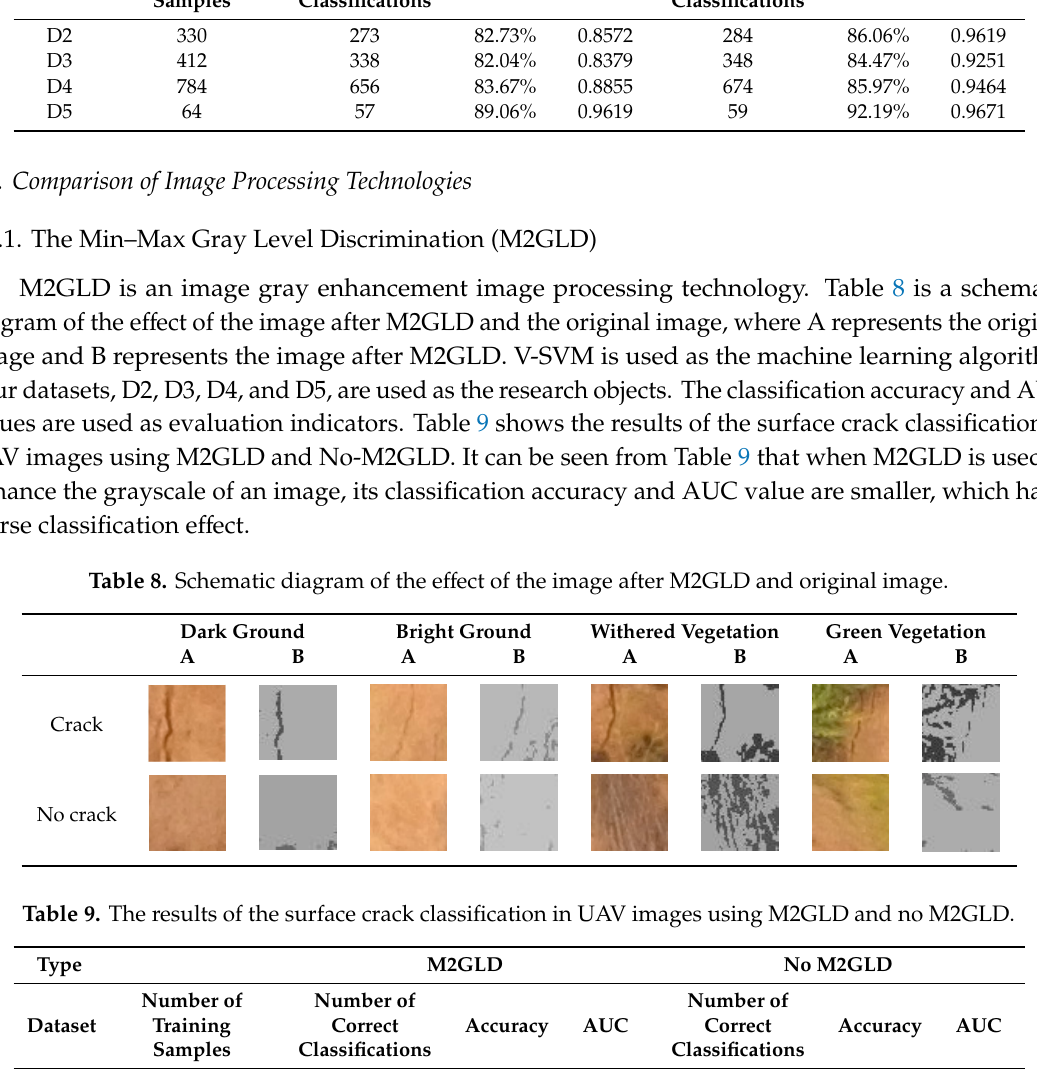
Table 9. The results of the surface crack classification in UAV images using M2GLD and no M2GLD. Type